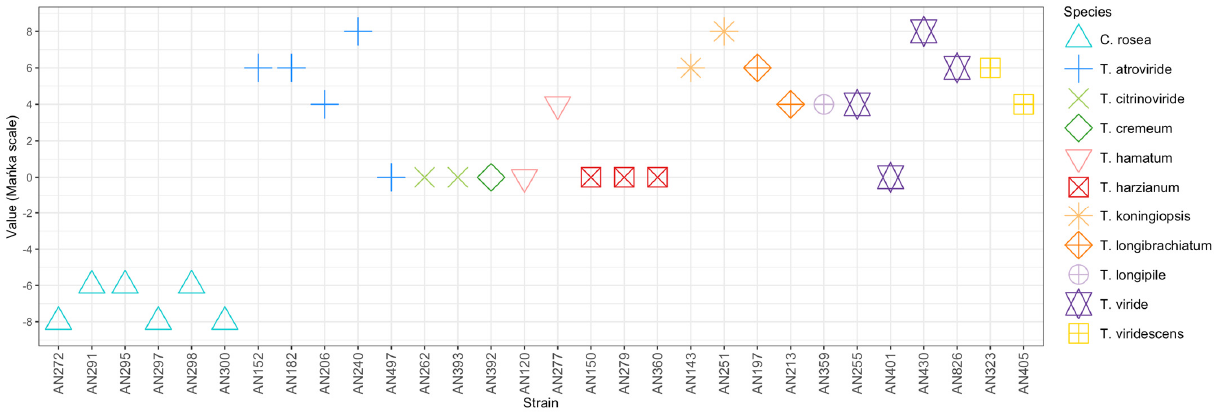
Clonostachys strains during 7 days of co–incubation in dual cultures on PDA medium.